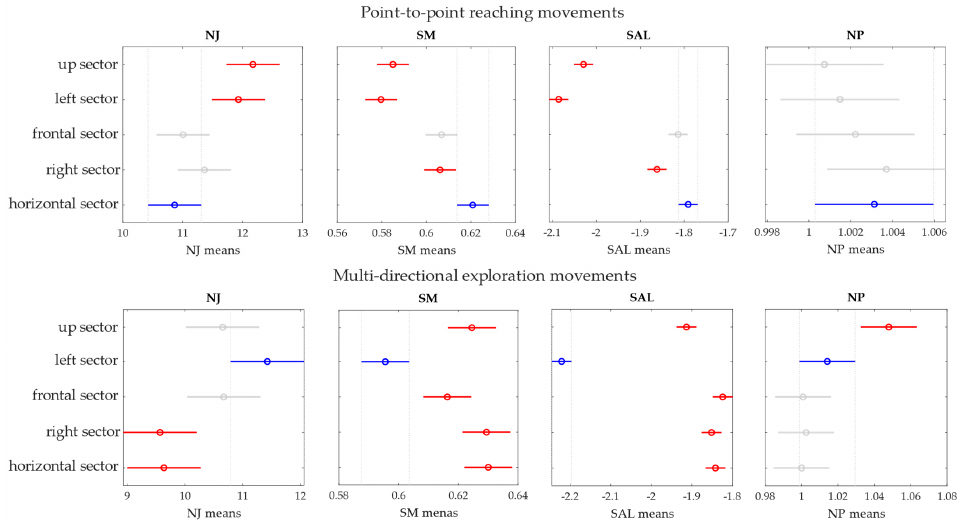
Figure 8. The statistical tests between sectors are reported for each metric (in the column). Both P2P (first row) and EXP (second row) are reported. In P2P movements, the NJ in the frontal and the horizontal sectors was significantly lower than the NJ in the up ( p = 0.003, p = 10 − 4 ) and left sectors ( p = 0.04, p = 0.01). The SM was significantly higher in the frontal, right and horizontal sectors with respect to the up ( p = 10 − 4 , p = 10 − 4 , p = 10 − 11 ) and left ( p = 10 − 6 , p = 10 − 6 , p = 10 − 14 ) sectors. Moreover, the SM in the right sector was lower than in the horizontal sector ( p = 0.04). The SAL was signifi- cantly lower in the left ( p = 10 − 14 ) and in the up ( p = 10 − 14 ) sectors. Moreover, the SAL in the right sector was higher than in the right sector ( p = 0.02) and in the horizontal sector ( p = 10 − 4 ). The NP, instead, was not significantly different between sectors. In EXP movements, the NJ in the left sector was significantly higher than for the right ( p = 10 − 4 ) and horizontal ( p = 0.001) sectors, while the SM was lower in the left sector ( p < 10 − 3 ) with respect to the other sectors. The SAL in the left sector was significantly lower than the other sectors ( p < 10 − 3 ) and was lower in the up sector ( p < 10 − 3 ) with respect to the frontal, right and horizontal sectors. Finally, the NP was higher in the up sector ( p < 0.02). Correlation plots between each possible pairs of metrics are shown for each repetition and subject in Figure 9 for the P2P movements and in Figure 10 for the EXP movements.